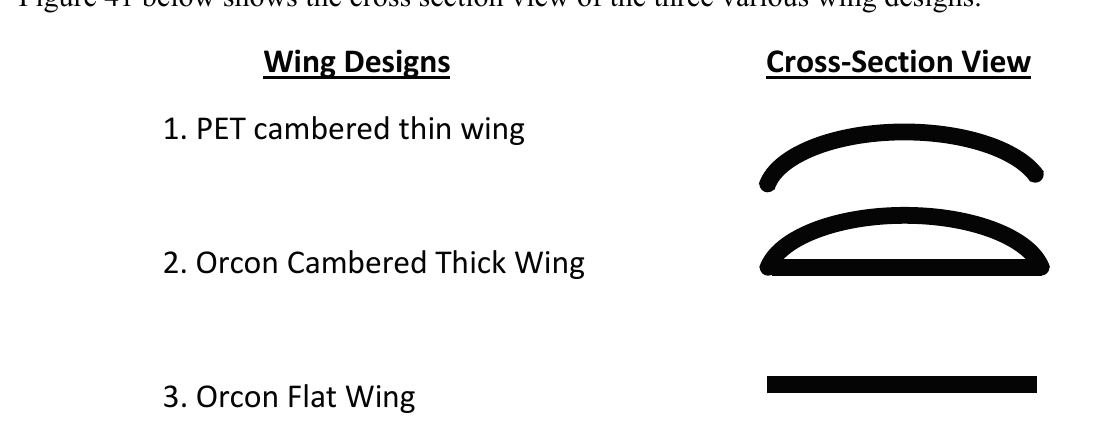
Figure 41. Cross-section view of the three different wing